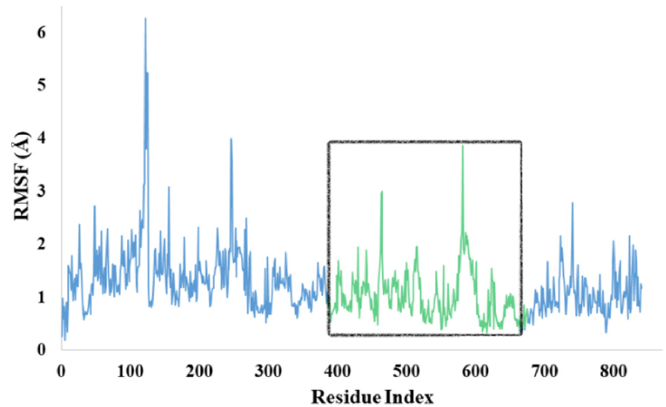
Figure 8. Root mean square fluctuation [RMSD] graph against time for Urease- 4i complex. Green peaks are representing amino acid residues of active site.